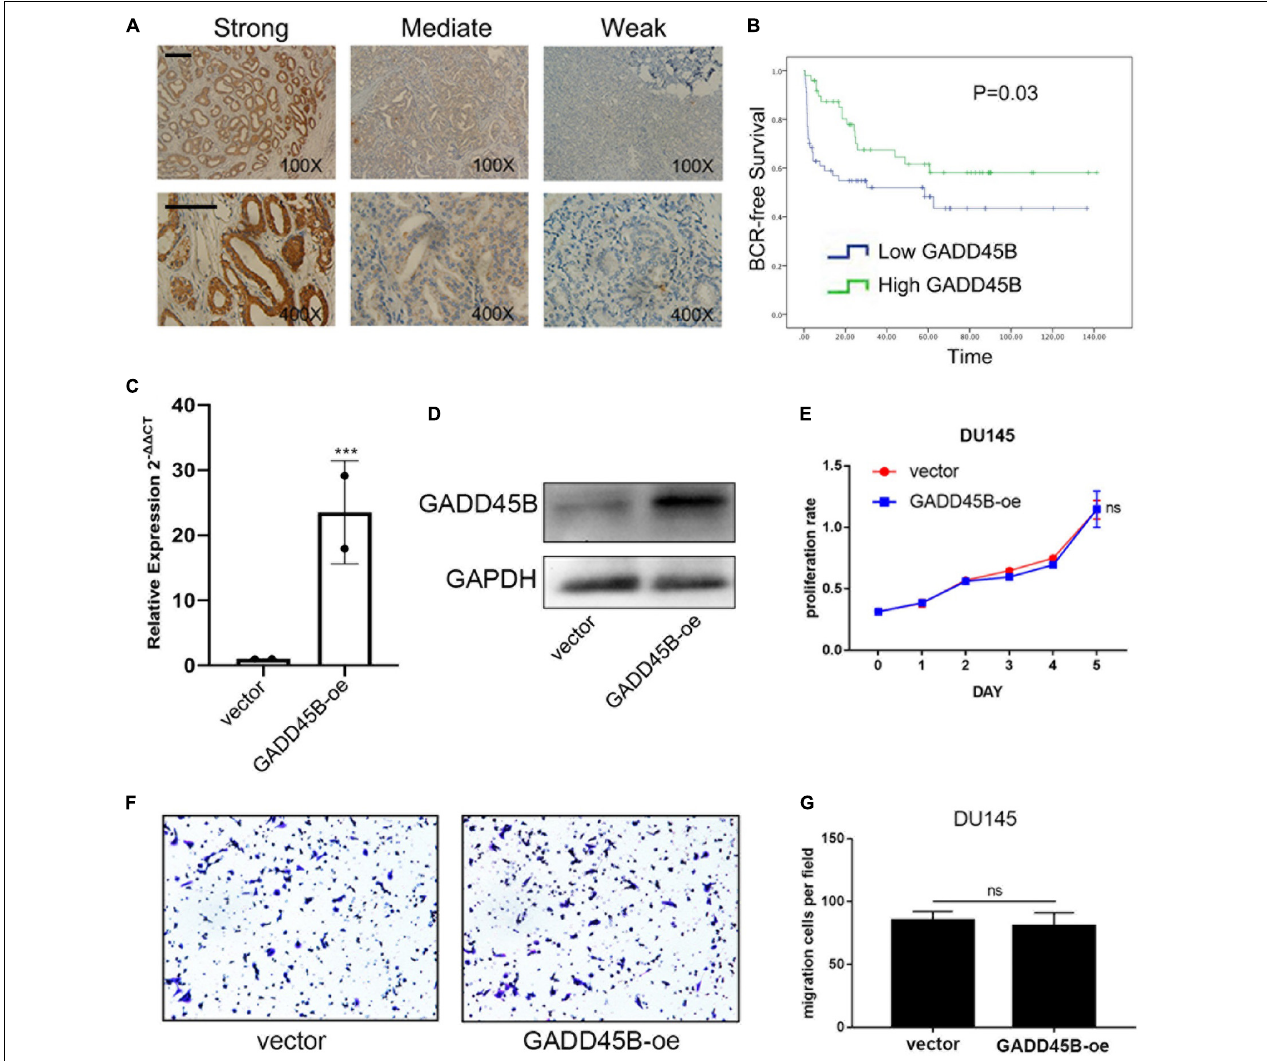
FIGURE 2 | GADD45B predicted a good prognosis and had no effect on the proliferation and migration of PCa cells. (A) Representative immunohistochemical staining and quantification showed the expression level of GADD45B in PCa tissues of patients from Sun Yat-sen University Cancer Center. Magnification 100 × , scale bar = 200 µ m, Magnification 400 × , scale bar = 100 µ m. (B) Biochemical recurrence survival analysis of GADD45B in patients form Sun Yat-sen University Cancer Center. (C,D) RT-PCR and WB analysis of GADD45B levels in GADD45B-overexpressing DU145 cell line. (E) The MTS assay test of cell viability of DU145 cells with GADD45B overexpression. (F,G) Representative images and histogram analysis of migration assays after upregulation of GADD45B. *** p < 0.001 and not statistically significant p >